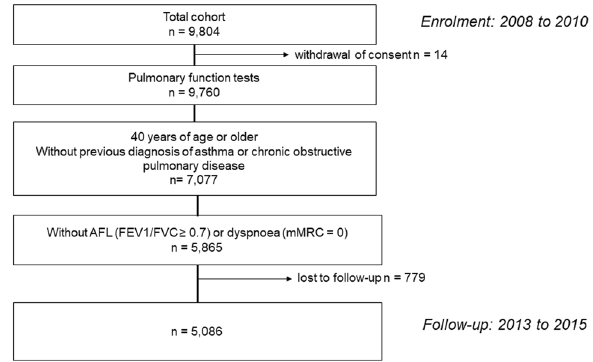
Figure 1. Flowchart of the data extraction process of the Nagahama Study. AFL airflow limitation, FEV 1 forced expiratory volume in 1 s, FVC forced vital capacity, mMRC modified Medical Research Council (mMRC) dyspnoea